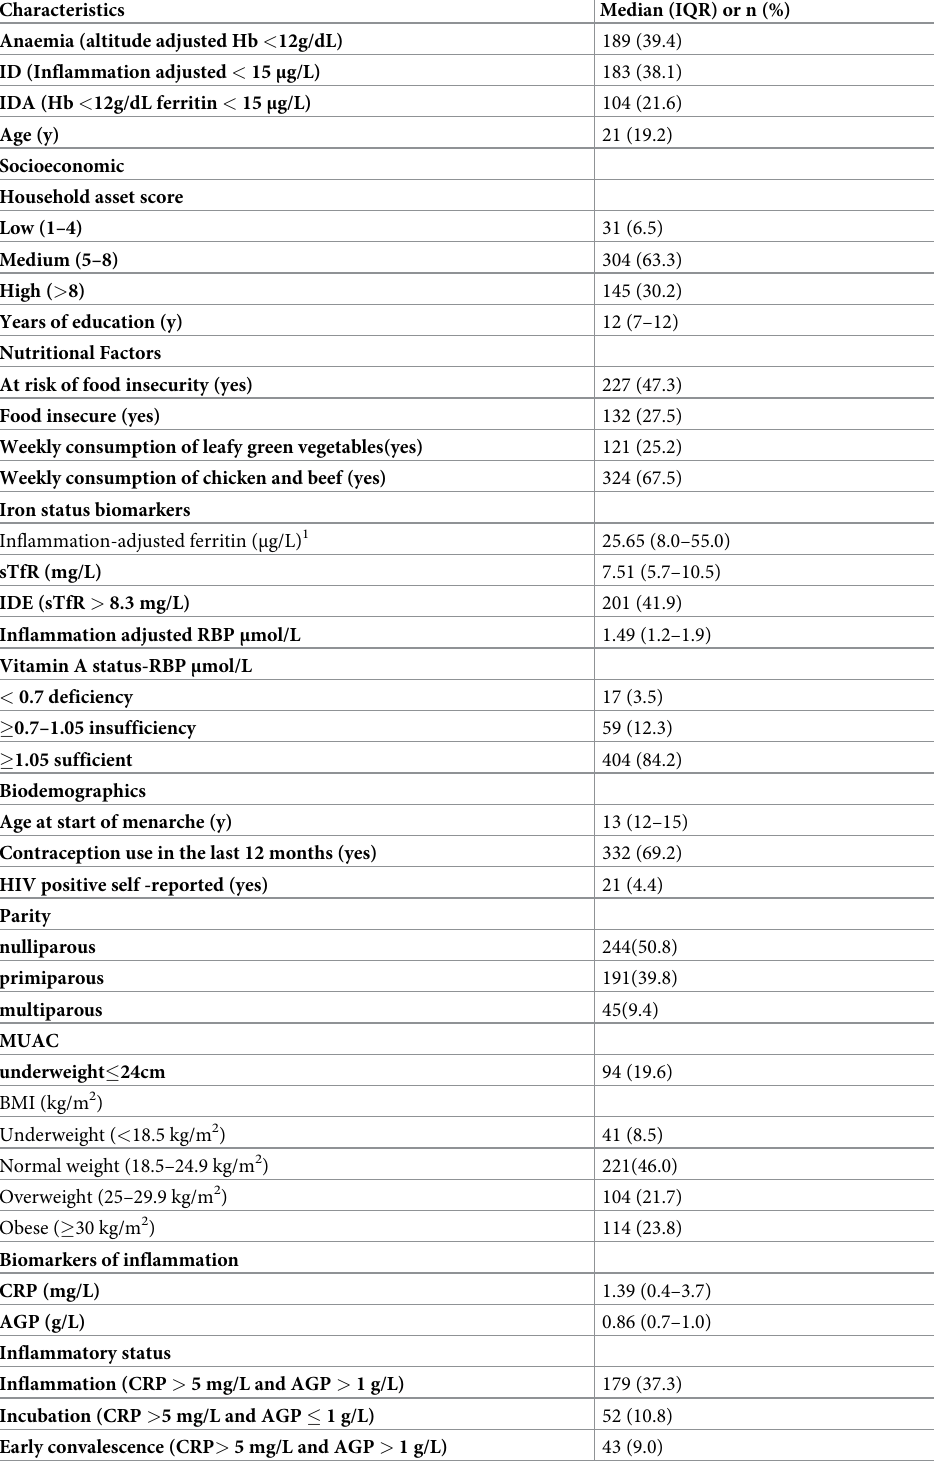
Table 1. Characteristics of 18–25-year-old non pregnant women of reproductive age residing in Soweto, South Africa (n =